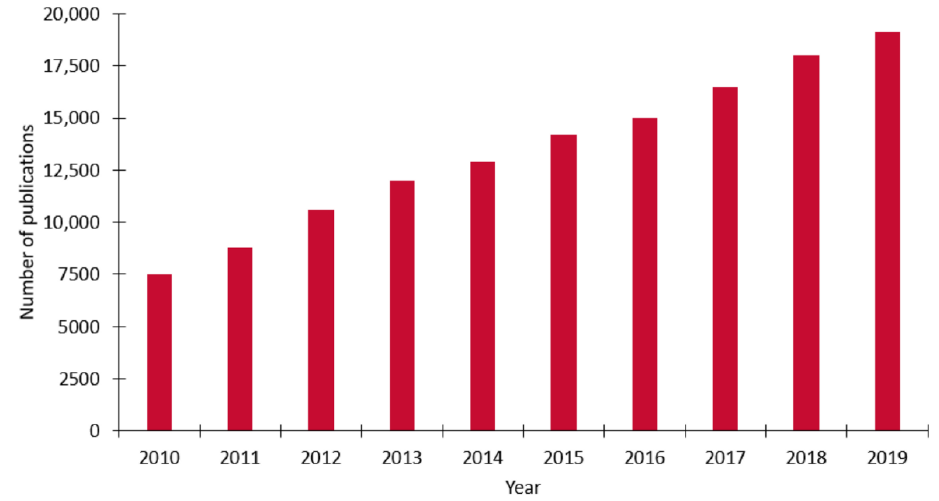
Figure 3. The number of publications per year found in the Google Scholar database using the search term “microbial fuel cells” (MFCs); (data acquired on 29 October 2020) (Reprinted with permission from Ref. [50]).